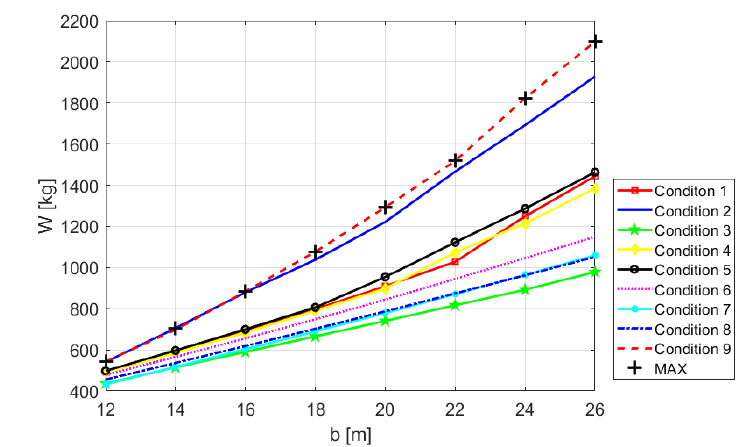
Figure 5. Weight estimation of V-tail for the nine conditions studied, for variation in span and for the parameters Γ = 30º, c r = 3.7 m and λ = 0.32.